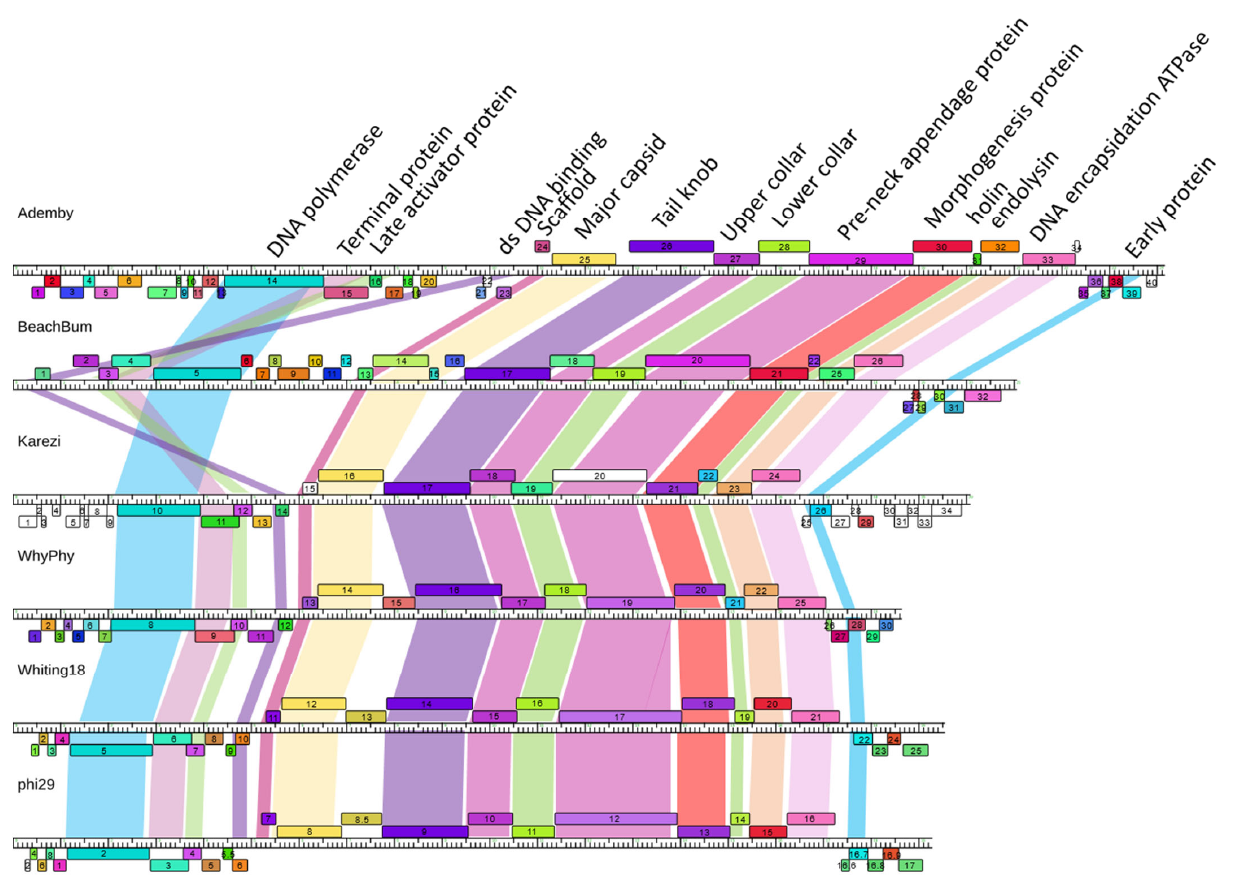
Figure 4. Maintenance of synteny and function in representative genomes. The regions between fifteen protein families were shaded according to the color of the protein pham in Ademby to highlight conservation of protein function throughout these diverse phage genomes. A full collection of Phamerator maps is available in Supplementary Figure S1.